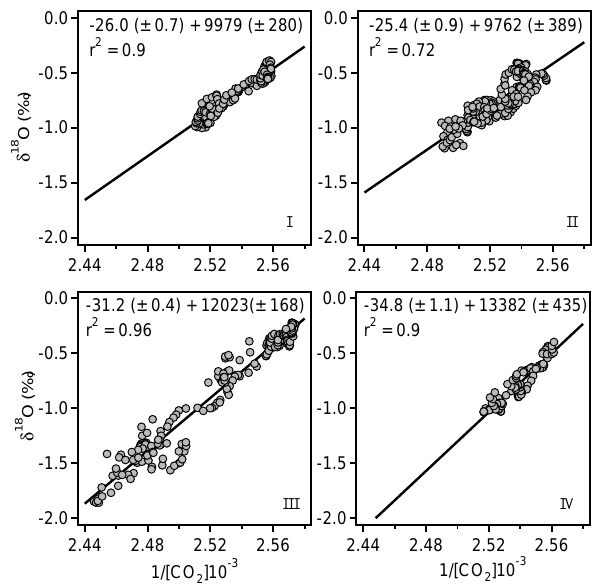
Fig. 5. Keeling plots for data collected during the individual pollu- tion events. δ 13 C values representing one hour aggregates are plot- ted against the inverse of CO 2 mixing ratio. The intercept and the slope of the ordinary least square linear regression is given together with their 1 σ uncertainties.